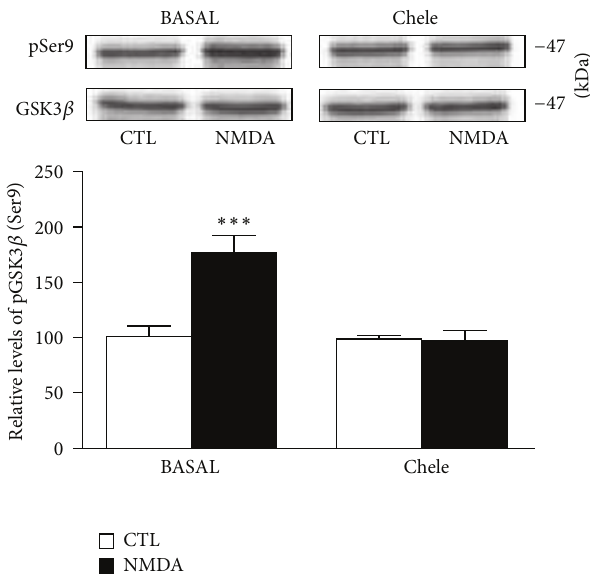
Figure7:NMDA-inducedchangesinGSK3 𝛽 Ser9phosphorylation are mediated by PKC activation. Phosphorylated GSK3 𝛽 levels at Ser9 and Tyr216 epitopes were estimated by Western blotting of cell extracts obtained from hippocampal slices treated with 5 𝜇 M NMDA for 1 hour alone or in combination with the PKC inhibitor Chelerythrinechloride(Chele;1 𝜇 M).Thedataareexpressedrelative to total GSK3 𝛽 levels and as percentages of control values. They are the means ± S.E.M. of 3 measurements per cell extract obtained from 7 different rats. For statistical analysis, one-way ANOVA was followed by Newman-Keuls post hoc test. ∗∗∗ 𝑃 < 0.001 , drug-treated versus